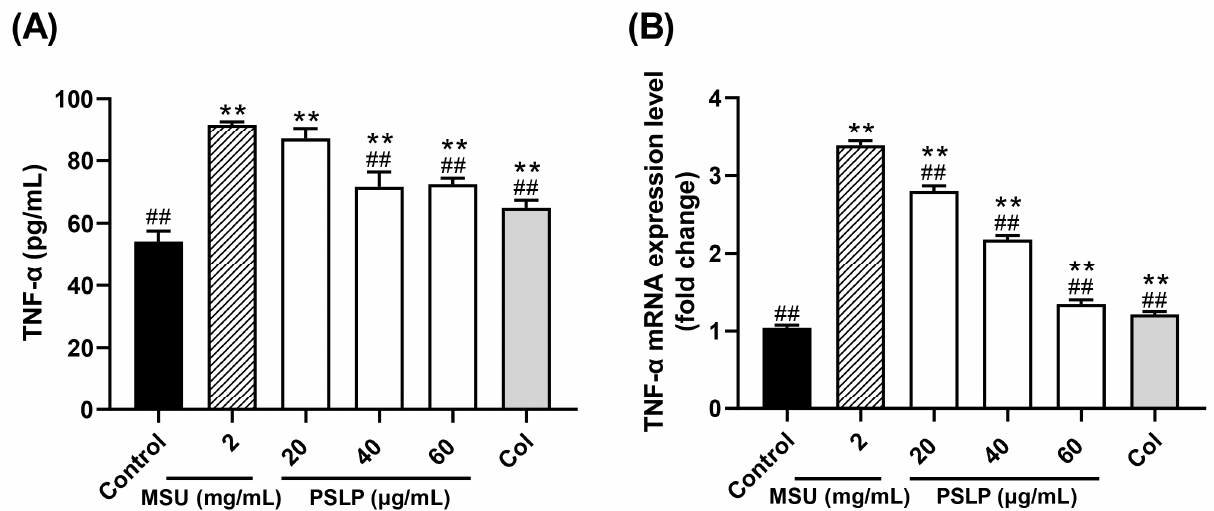
Figure 4. Effect of PSLP on TNF- α secretion ( A ) and its mRNA expression level ( B ) in MSU-stimulated RAW264.7 cells. The values were expressed as means ± SD ( n = 3), ** p < 0.01 vs. the control group. ## p < 0.01 vs. the MSU group.